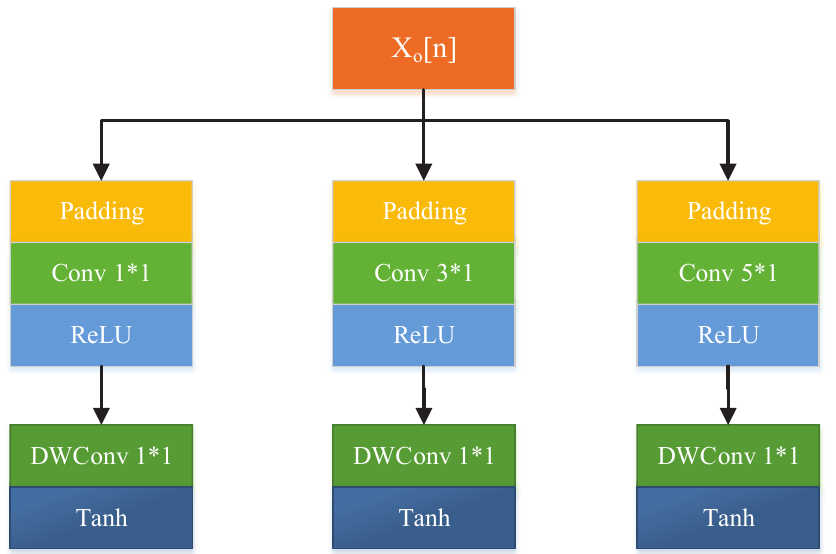
Figure 3. The structure of the updater. Padding in the updater denotes the reflection